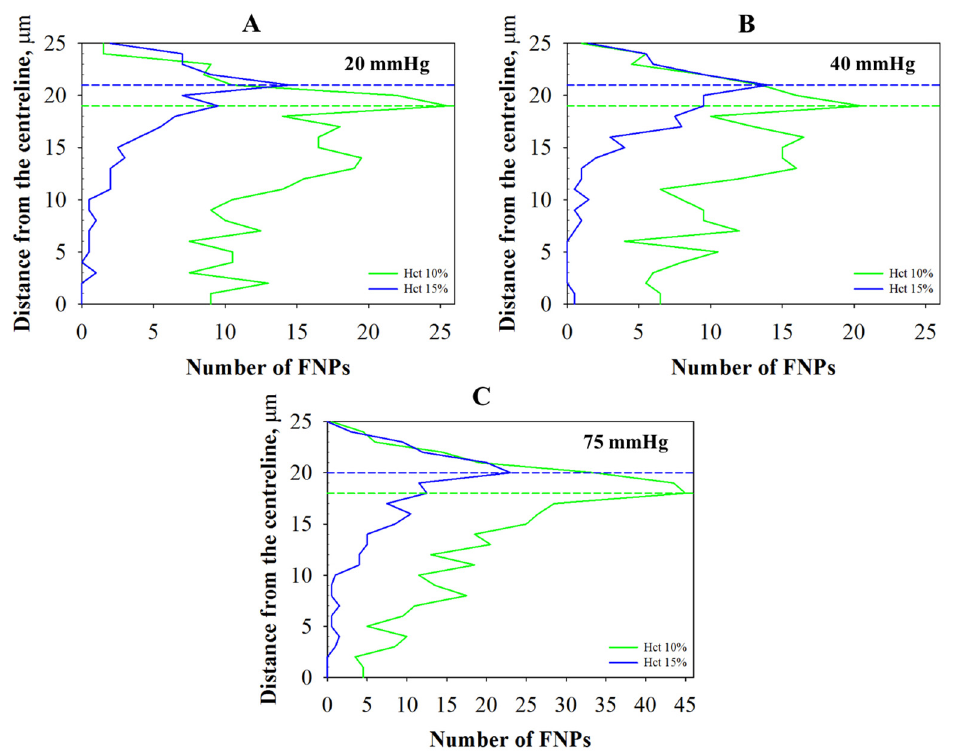
Figure 5. Distribution profiles of FNPs along radius at 10% Hct (green lines) and at 15% Hct (blue lines).FNP radial distribution at: ( A ) 20 mmHg; ( B ) 40 mmHg; and ( C ) 75 mmHg. Dashed lines indicate the cell-free layer (CFL) thickness measured at the corresponding shear rate. (For interpretation of the references to color in this figure legend, the reader is referred to the web version of this article).